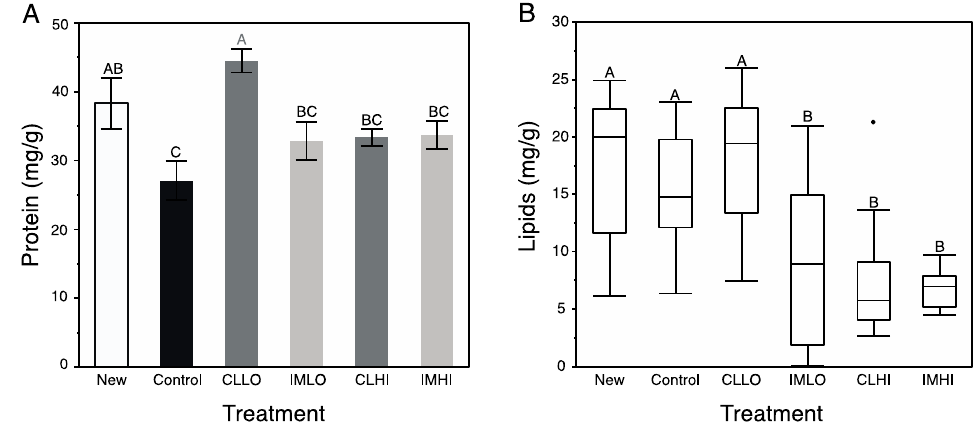
Figure 2. Mean ( ± s.e.m) weight of individual newly emerged honey bees and those from pesticide treatment groups after two weeks. White bar = Newly Emerged Treatment; Black bar = Control treatment; Dark grey bars = Clothianidin Low (CLLO) and High (CLHI) dose treatments; Light grey bars = Imidacloprid Low (IMLO) and High (IMHI) dose treatments. Letters above bars represent significant differences across treatments from Student’s post hoc tests.